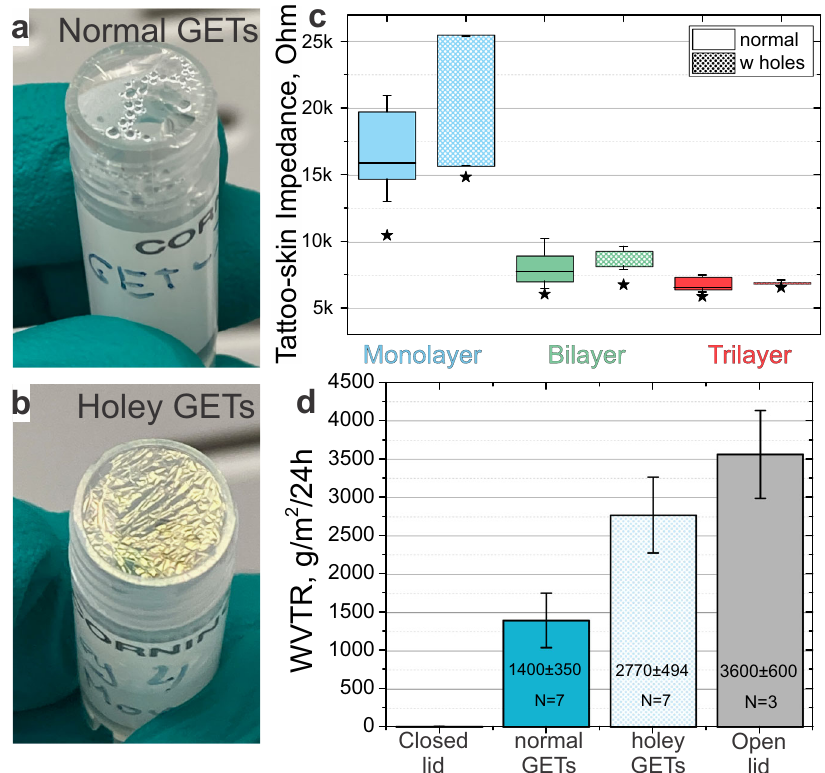
Fig. 3 Comparison between normal GETs and holey GETs. a Photograph of a vial capped with normal GET, impeding normal evaporation of the water trapped inside. b Photograph of a vial capped with holey GET, without water condensation on the surface, suggesting that it is ef fi ciently evaporated. c The change in GET performance (tattoo-skin impedance) of the 1 L (ice blue), 2 L (light green), and 3 L (red) GETs with and without holes. The box represents 25% and 75% with a mean, whiskers are ±SD, and stars represent the best examples. d The water vapor evaporation rate difference between a closed vial (with cap), capped with a normal 1L-GET (blue), capped with a holey 1L-GET (dotted blue), and an entirely open one (gray). The vials and their water content were monitored for 7 days, and the average data per 24 h is shown. See Supplementary Fig. 10 for complete water loss dynamics. The box represents 25% and 75% with a mean, whiskers are